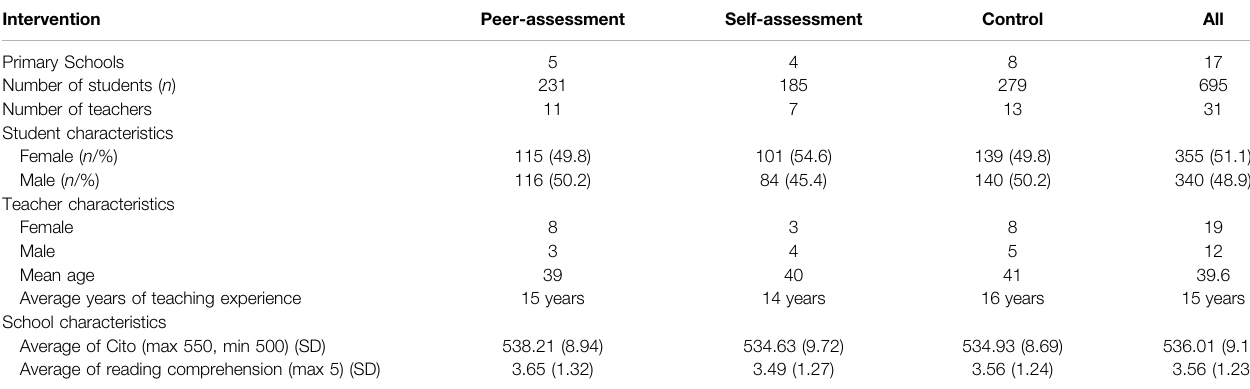
TABLE 1 | Description of the sample for the pretest and posttest by